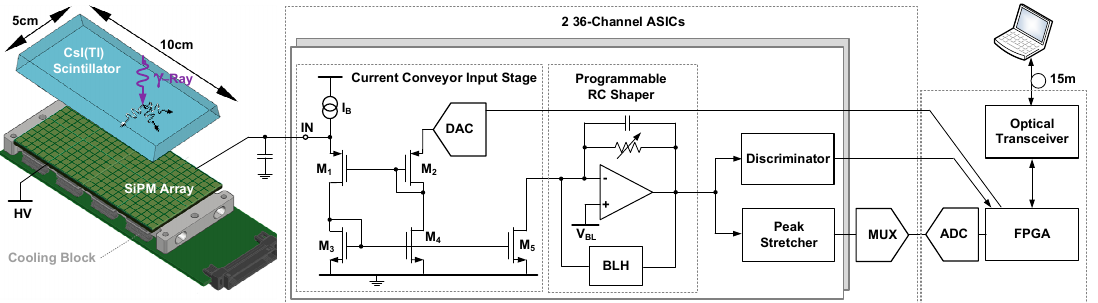
Figure 7. Architecture of the gamma camera of the INSERT SPECT system: the current signals of 72 silicon photo-multiplier (SiPM) pixels are read by two ASICs [43], featuring a low-impedance input stage, programmable shaper, peak stretcher and fast comparator to trigger the acquisition of events by the FPGA-based DAQ unit [44].